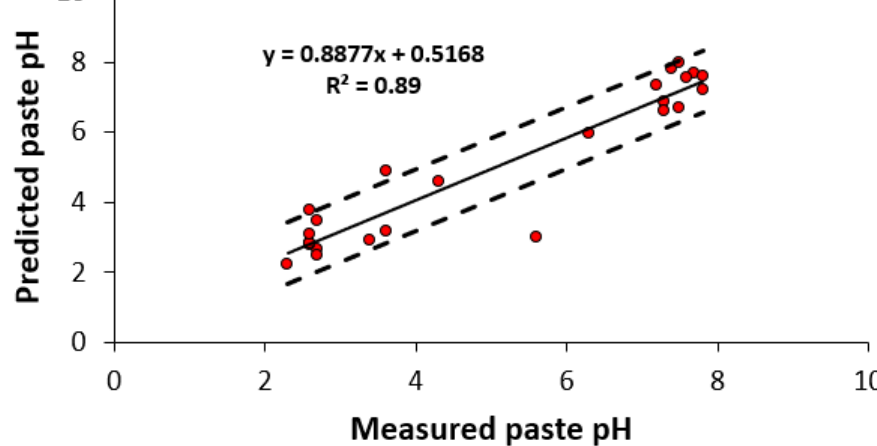
Figure 4. Results of kriging validation: measured paste pH vs predicted paste pH by kriging.